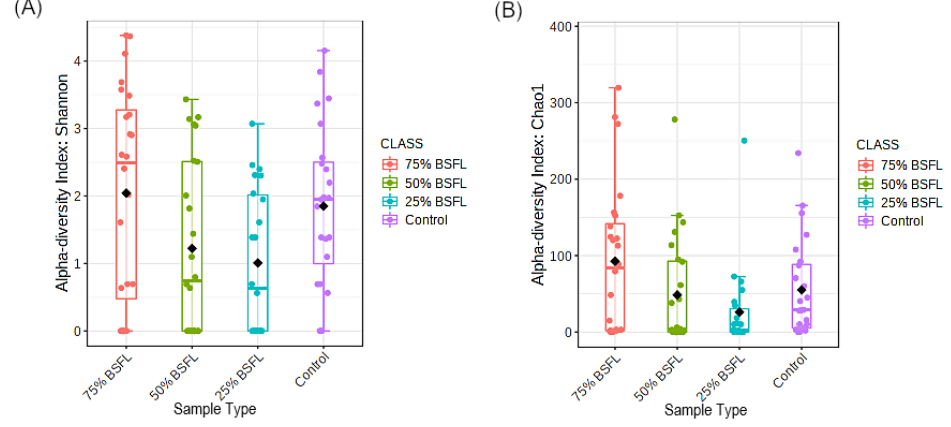
Figure 5. Alpha diversity estimate measures by ( A ) Shannon index and ( B ) Chao1 index from the gut bacterial profiles of our samples.